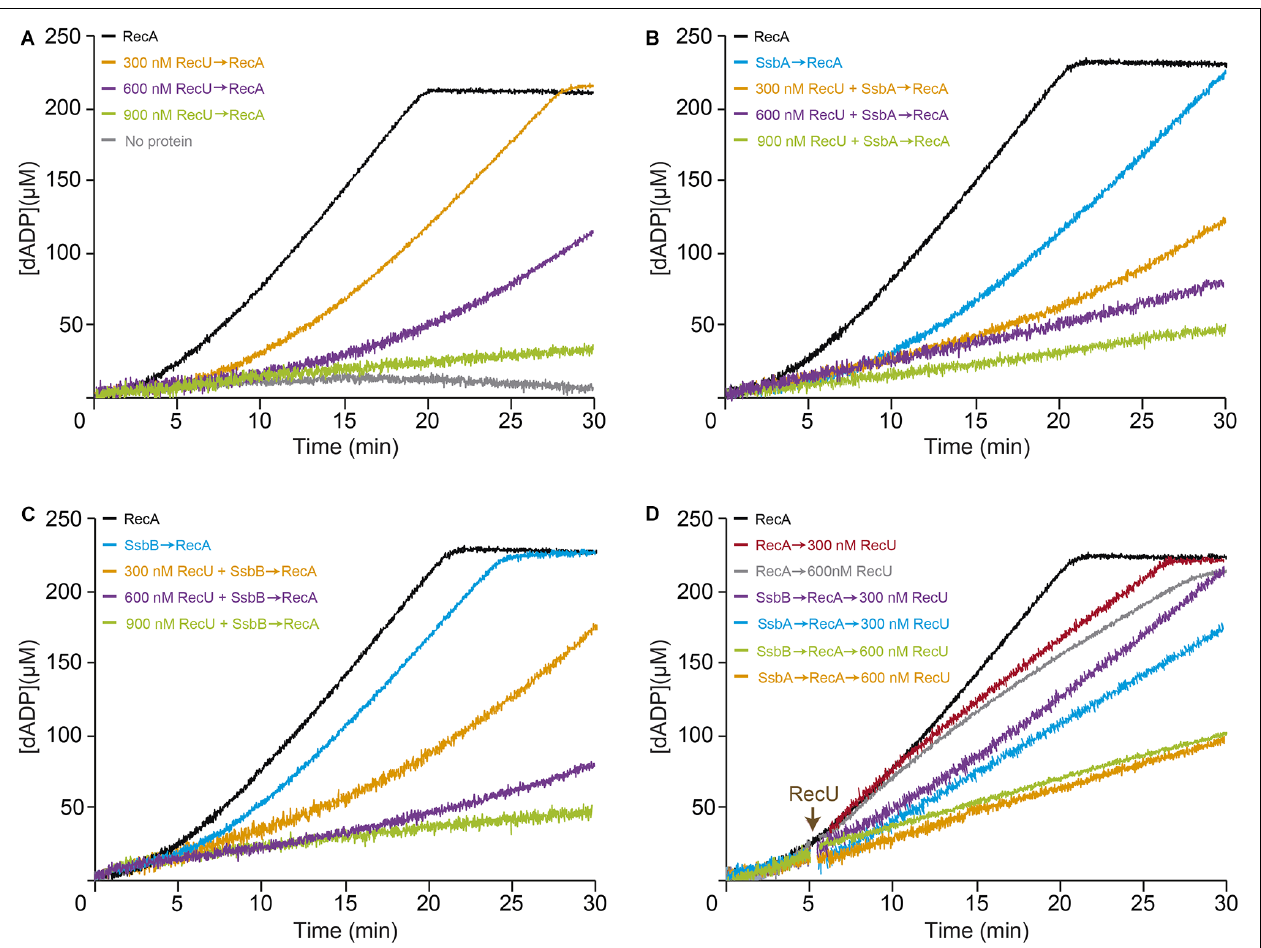
FIGURE 4 | Effect of RecU on RecA nucleation on ssDNA and filament growth in the presence of dATP. Circular 3,199-nt ssDNA (10 µ M in nt) was preincubated with increasing RecU concentrations (A) and a fixed amount of SsbA (B) or SsbB (C) (300 nM) (5 min, 37 ◦ C) in buffer B containing 5 mM dATP. RecA (0.8 µ M) was added and dATPase activity was measured (30 min, 37 ◦ C). (D) ssDNA was preincubated with a fixed concentration of RecA and SsbA or SsbB (5 min, 37 ◦ C), followed by increasing RecU concentrations, and dATPase activity was measured. The amount of dATP hydrolyzed was calculated as described. Representative graphics are shown here and quantification of the results is expressed as the mean ± SEM of > 3 independent experiments (see Supplementary Table